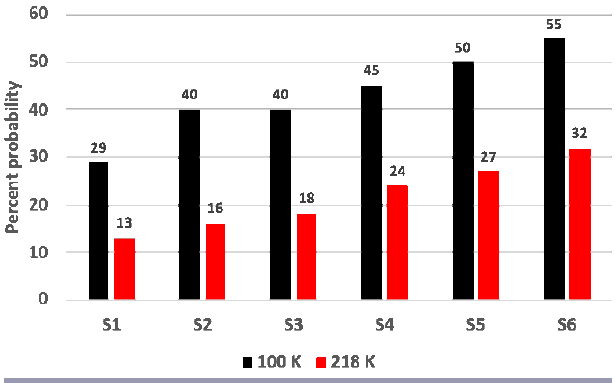
Fig. 7 . Percent probability of a decline in the Porcupine Caribou Herd under six development scenarios for a starting population size and 100,000 and